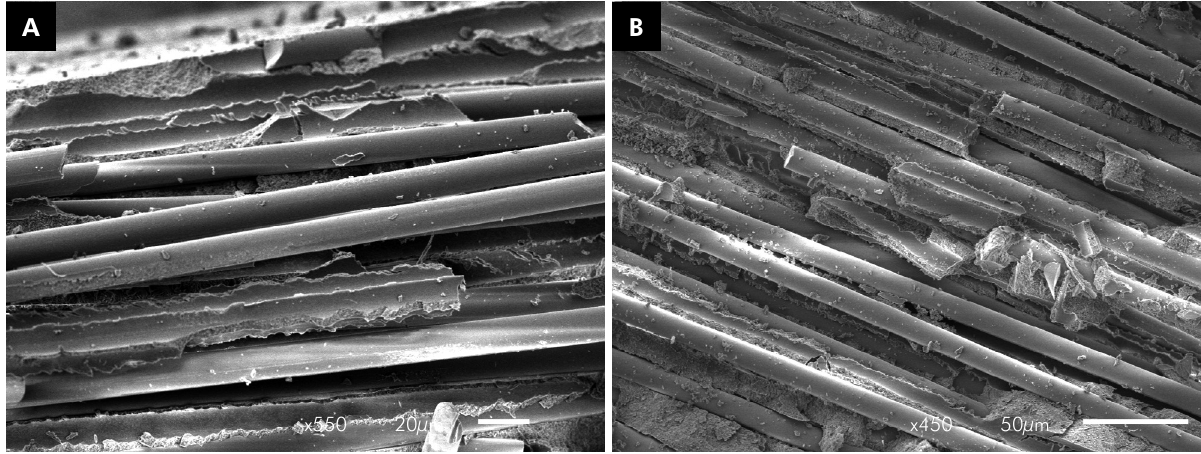
Figure 7. SEM analysis revealing the interaction between the fibers and resin matrix in groups that were or were not preheated.